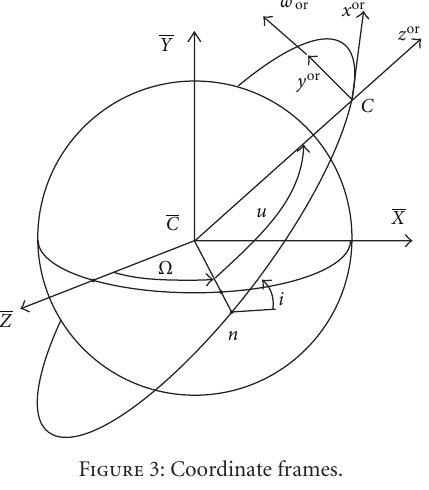
Figure 2: Generalized mechanical model of spacecraft with deploy- able designs.